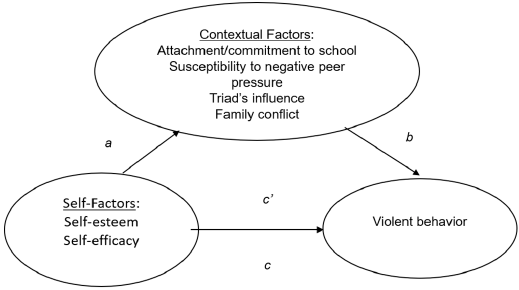
Figure 1. Conceptual path model of violence. Path c and c’ indicates total and direct effects, respectively, whereas paths a × b indicates the indirect effect.